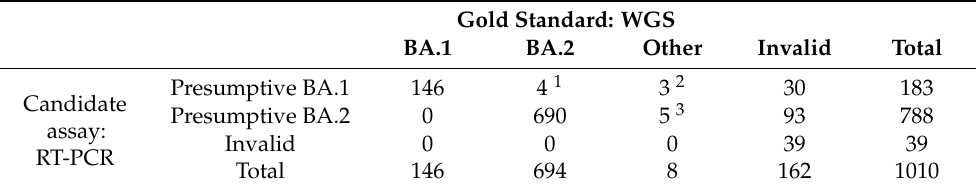
Table 4. Overall assay performance comparison against gold standard